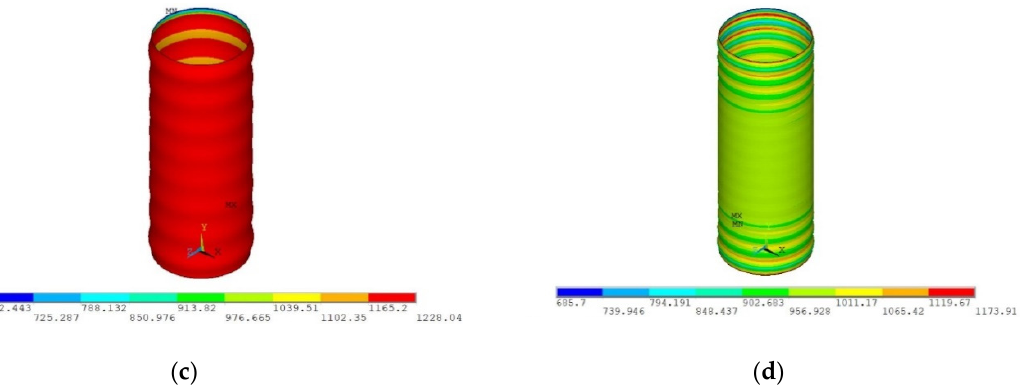
Figure 10. Stress through tube length and failure mode of D / t = 10, 40, 50, and D / t = 250 (LC1, S1100). ( a ) D / t = 10. ( b ) D / t = 40. ( c ) D / t = 50. ( d ) D / t = 250.